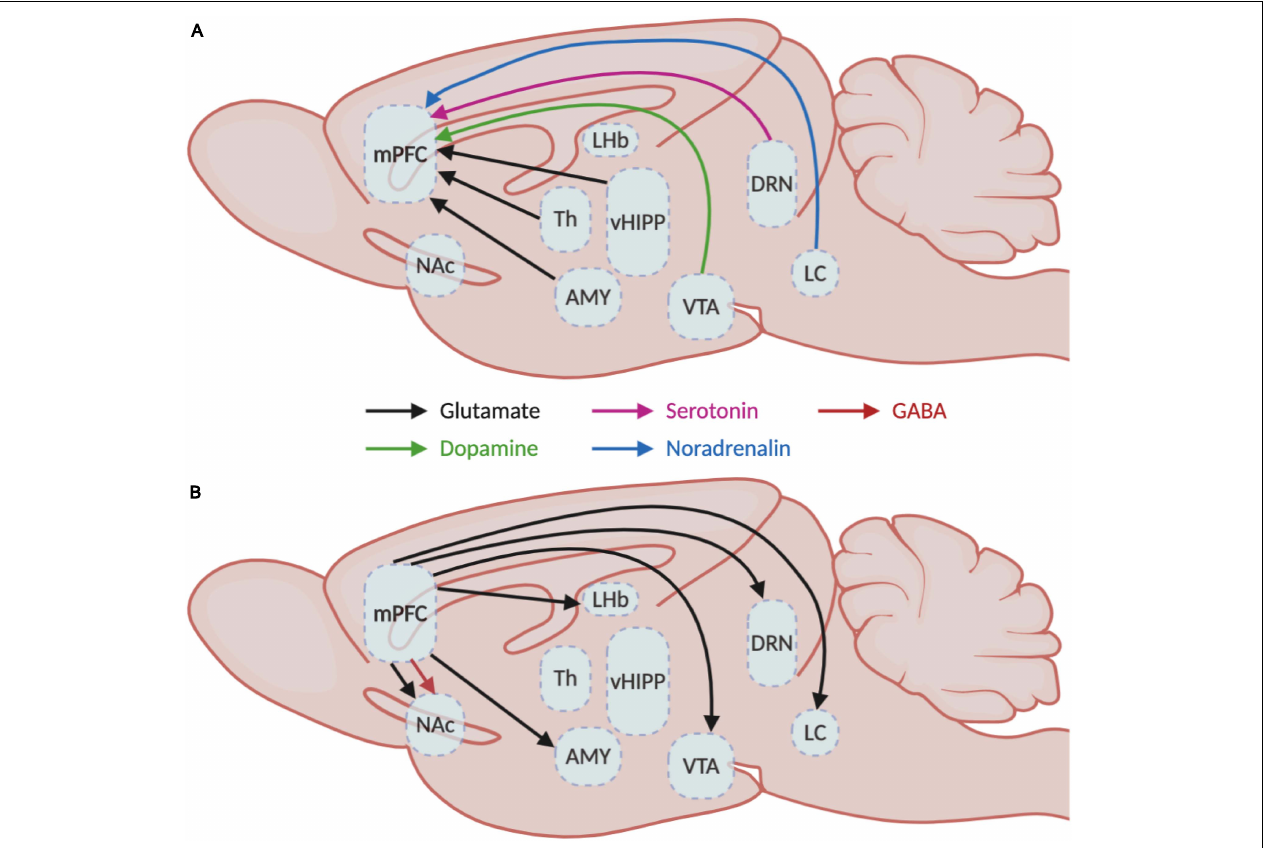
FIGURE 1 | Medial prefrontal cortex inputs and outputs. Schematic representation of the (A) afferent and (B) efferent projections in the medial prefrontal cortex with their respective neurotransmitter systems. AMY, amygdala; DRN, dorsal raphe nucleus; LC, locus coeruleus; LHb, lateral habenula; mPFC, medial prefrontal cortex; NAc, nucleus accumbens; Th, thalamus; vHIPP, ventral hippocampus; VTA, ventral tegmental